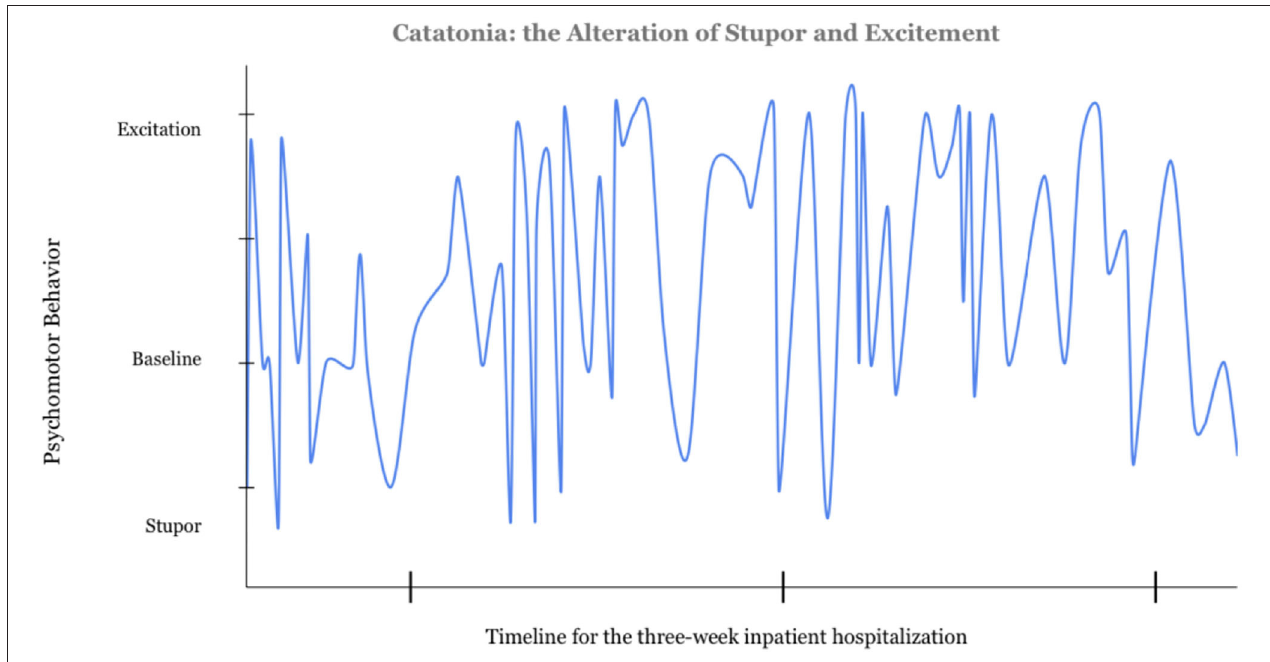
FIGURE 1 | Catatonia: the Alteration in Stupor and Excitation. The data for this graph was gathered from the nursing notes documented over the course of a 3-week admission prior to the diagnosis of catatonia. Four of the authors independently reviewed the notes and rated the psychomotor behavior from − 2 to + 2. Excitation was scored as a 2, stuporous catatonia was rated a negative 2. Further information on this scale can be found in the Supplementary Material